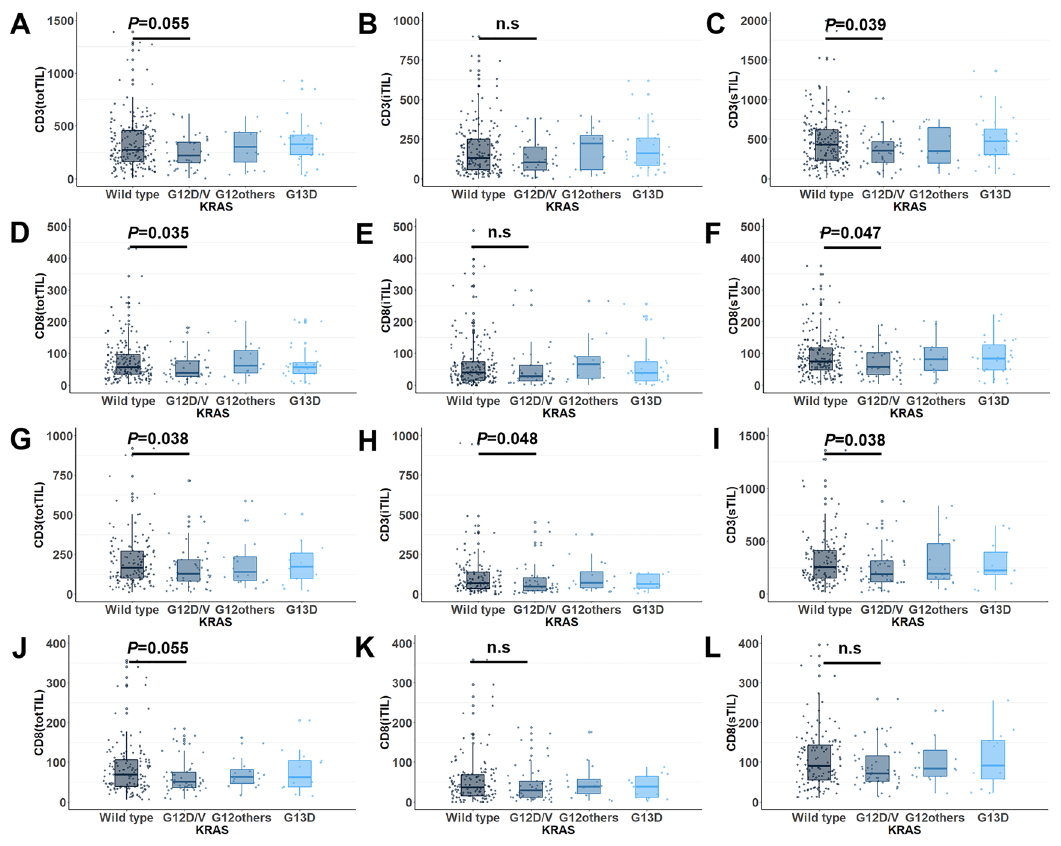
Figure 2. Density of tumor-infiltrating lymphocytes according to the KRAS mutation status in the ( A – F ) discovery cohort and ( G – L ) validation cohort.